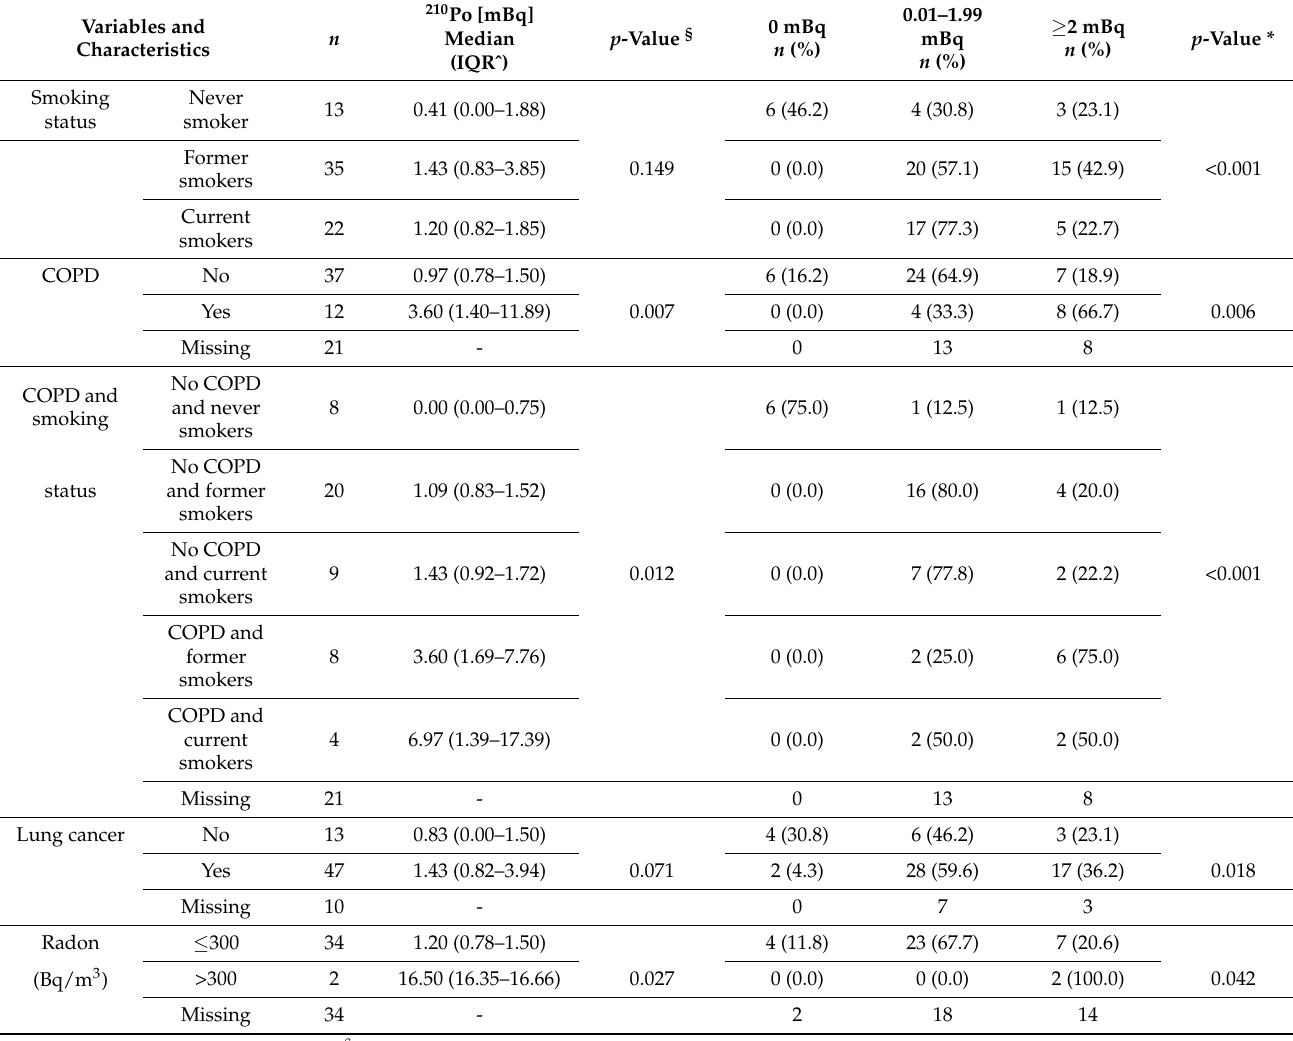
Table 2. Levels of 210 Po in 70 patients with suspected lung cancer from the “Polonium in vivo” study by smoking status and by having or not COPD or lung cancer (if 210 Po activity was below the detection limit it was assumed to be zero). 210 Po Variables and n Characteristics